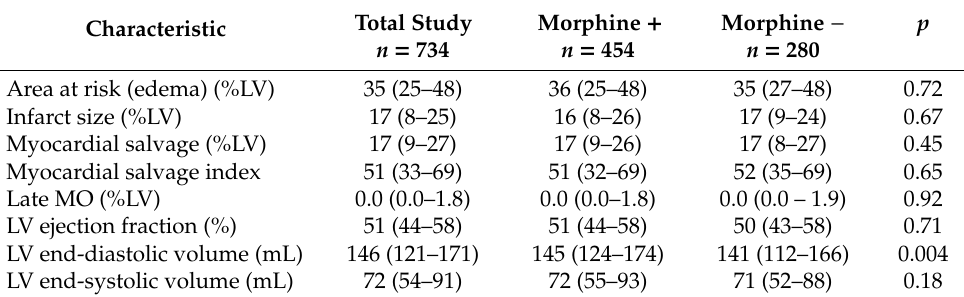
Table 2. Cardiovascular magnetic resonance